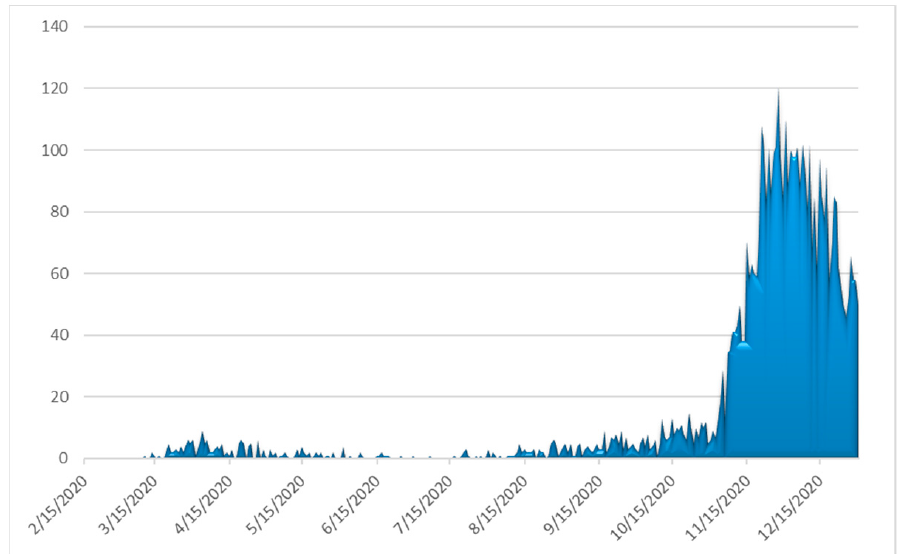
Figure 5. Observed daily confirmed number of deaths from COVID-19 complications in Greece (Data available from ECDC (https://www.ecdc.europa.eu/en/publications-data/covid-19-testing; accessed on 2 March 2021) .